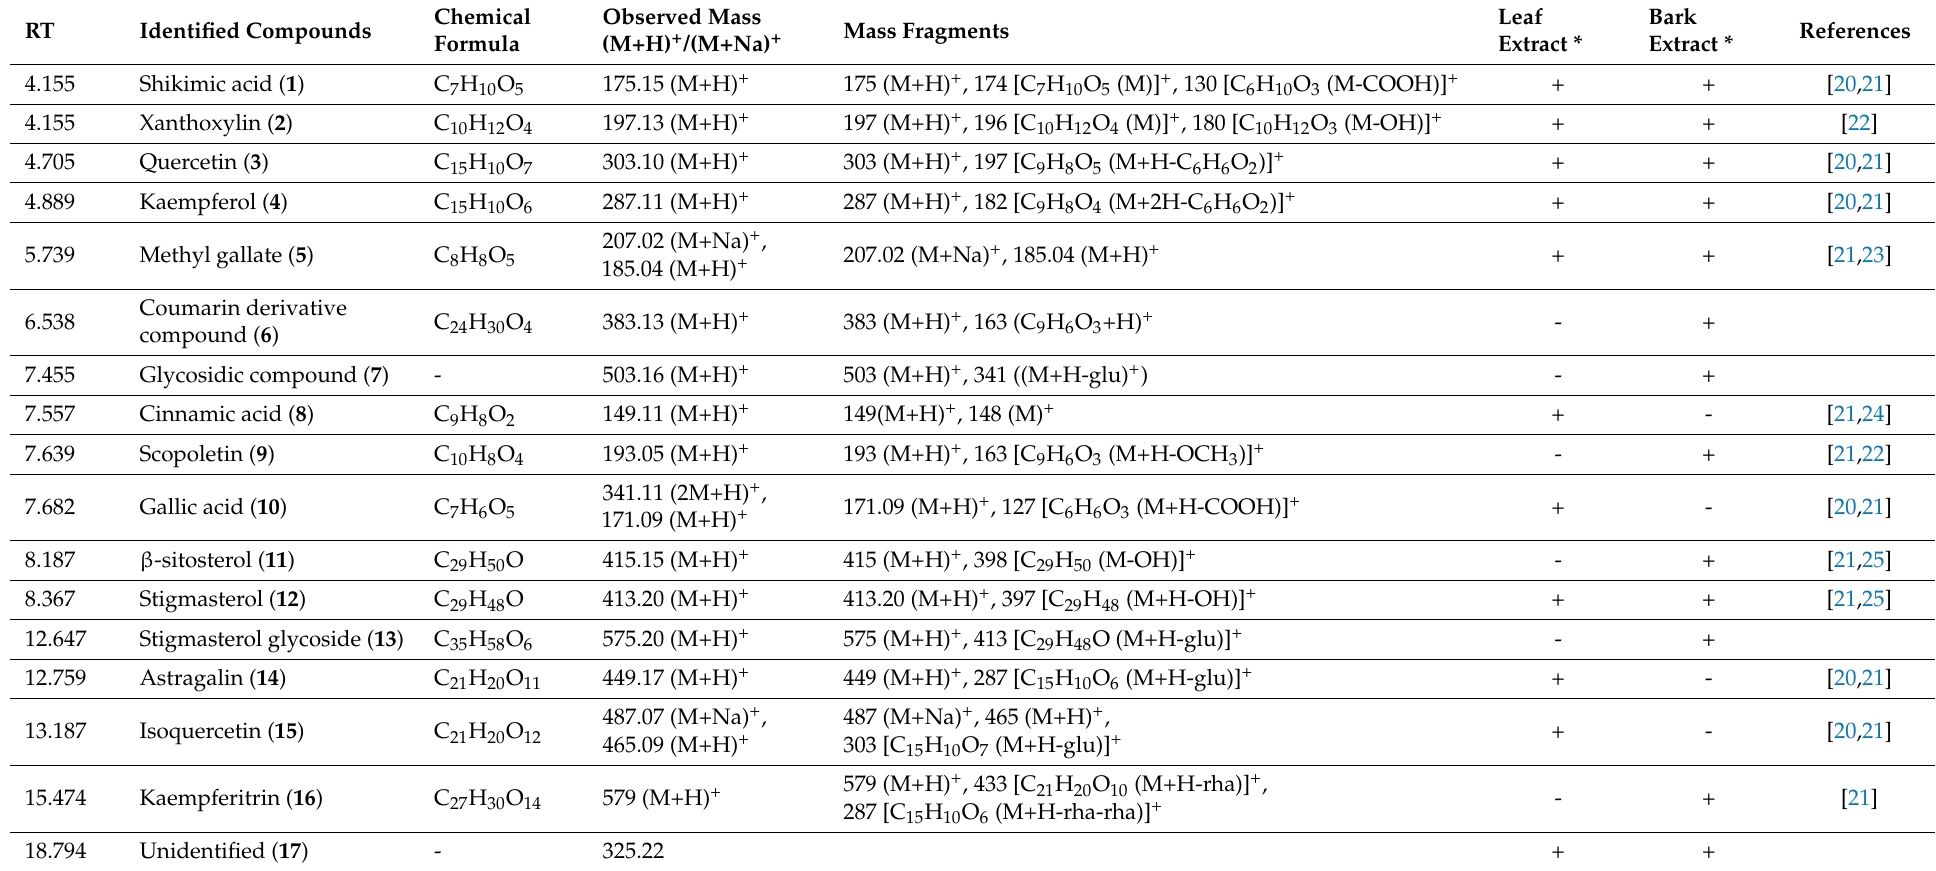
Table 1. Identified metabolites in leaf and bark ethanol aqueous extract of Triadica sebifera using